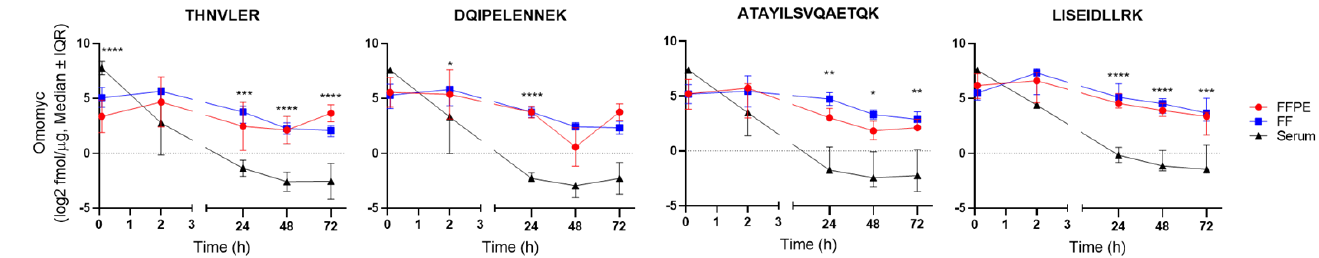
Figure 2. Absolute quantification of Omomyc in serum, FF, and FFPE tissue samples shows significant differences between the PK observed in tumor tissue compared with serum. Each representative peptide was quantified using single-point calibration (quantities derived from the ratios of endogenous to reference peak areas) and known spike-in amounts of SIS peptides. Data are shown as median interquartile range (IQR). * p < 0.05; ** p < 0.01; *** p < 0.001; **** p < 0.0001.